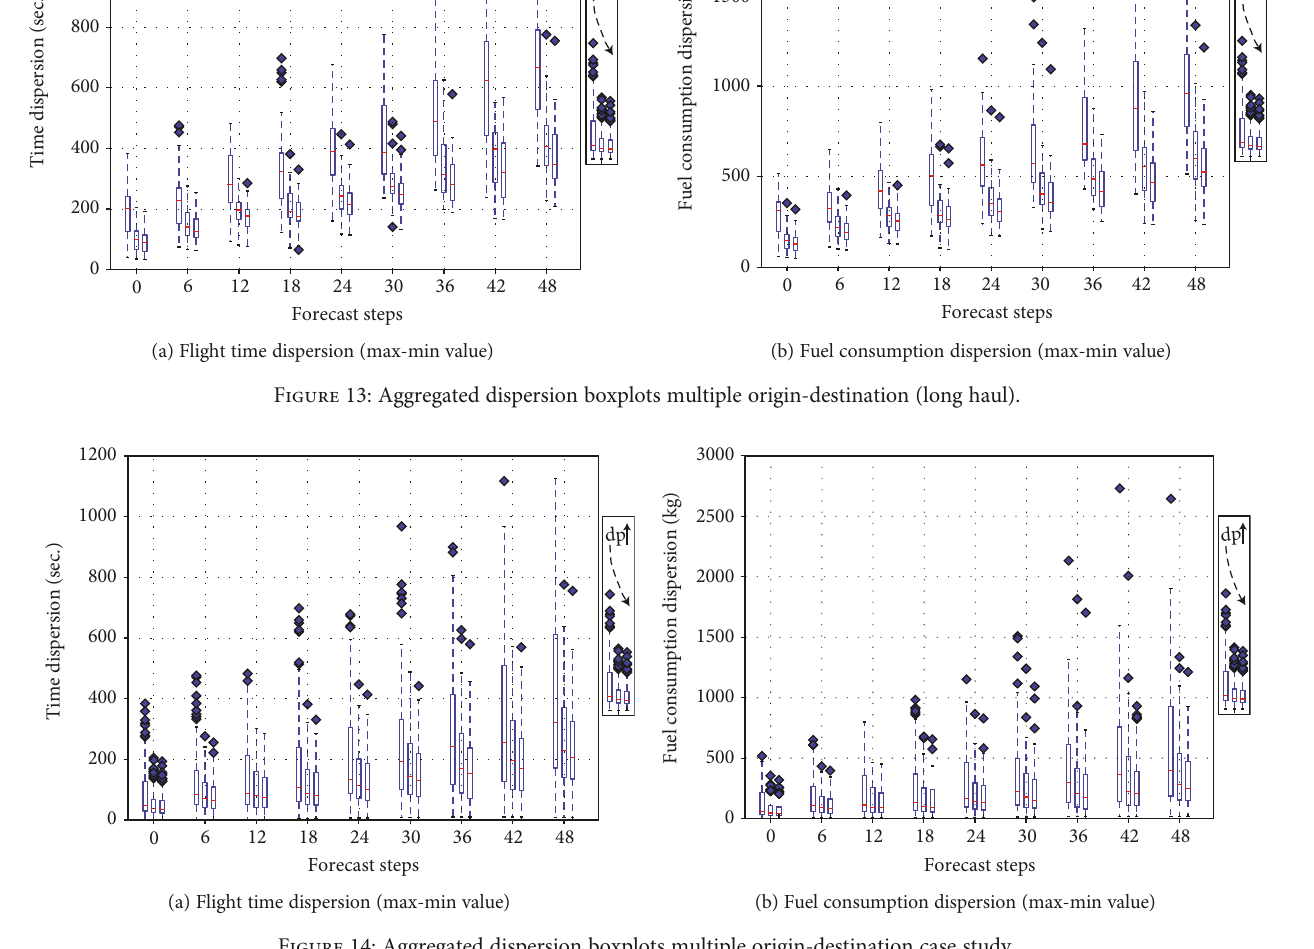
Figure 14: Aggregated dispersion boxplots multiple origin-destination case